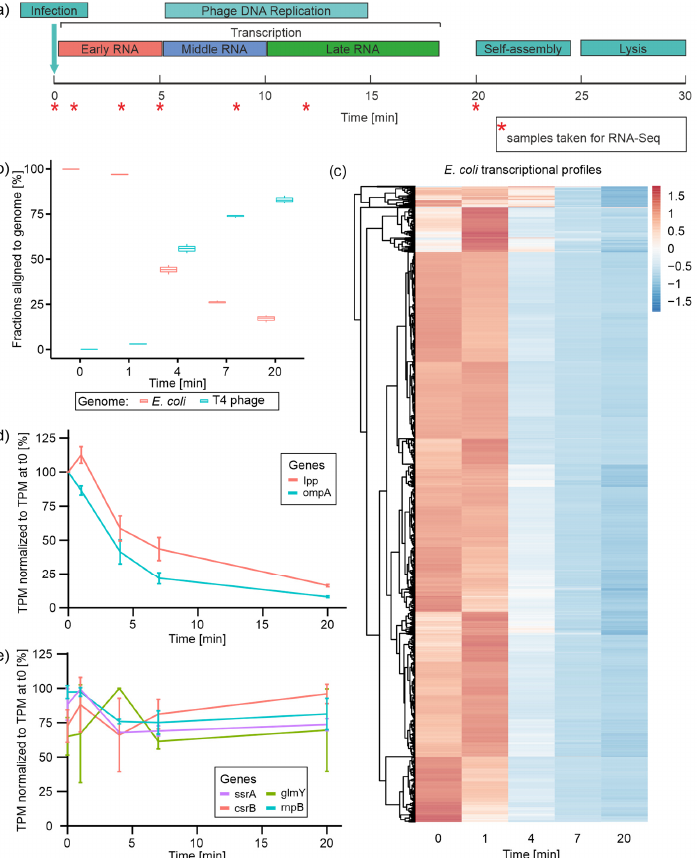
Figure 1. Time-resolved dual-RNA-Seq of T4 phage infection and the fate of host ( E. coli ) transcripts. ( a ) Schematic illustration of infection-phase-specific gene expression during T4 phage infection and indicated time points at which samples for dual-RNA-Seq have been taken. ( b ) Fractions of reads aligned to either E. coli or T4 phage genome over the time course of T4 phage infection calculated on the basis of TPM-normalized reads. ( c ) Heatmap of all E. coli genes’ TPM values normalized by z-score over the time course of infection. Genes are clustered according to expression profiles. ( d ) Plots of lpp and ompA mRNA levels over the time course of infection based on mean TPM values normalized to TPM value in uninfected E. coli (t0) [= 100%] for each RNA. ( e ) Plots of transcript levels of four comparably stable E. coli transcripts over the time course of infection based on mean TPM values, which were normalized to TPM value in uninfected E. coli (t0) [= 100%] for each RNA. 3.2. E. coli Transcript Degradation Is Initiated during the First 4 min of T4 Phage Infection During T4 phage infection, E. coli gene expression is globally shut off, whilst existing host transcripts are predominantly degraded [40]. This conception is mainly based on valuable studies describing the degradation of small subsets of host transcripts using elaborate rifampicin and Northern blot assays [9]. Thus, our dual-transcriptome approach provides the first comprehensive insights into all E. coli transcripts during T4 phage infection based on a single experiment.